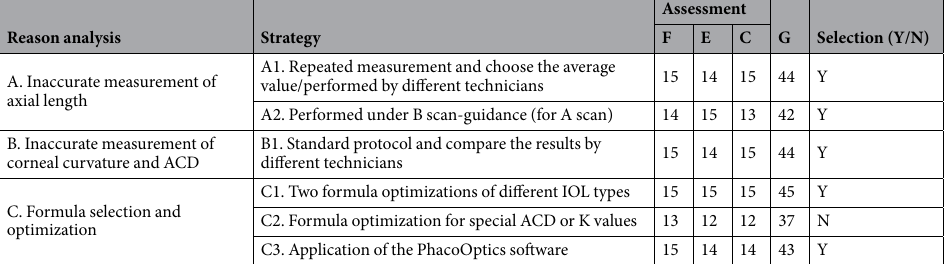
Table 1. Reason analysis and strategy assessment. F = Feasibility, E = Economy, C = Circle capacity, G = Grade, ACD = Anterior chamber depth, IOL = intraocular lens, Y = Yes, N = No. The strategy assessment was graded by two experienced doctors and 1 technician based on a 5-point system.